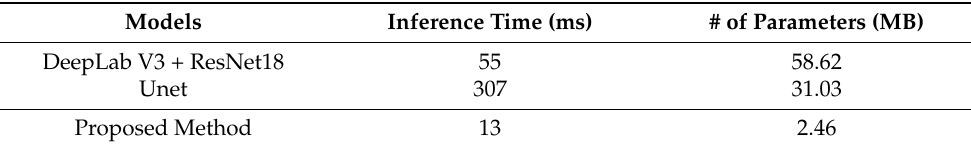
Table 7. Comparison of the computational and memory